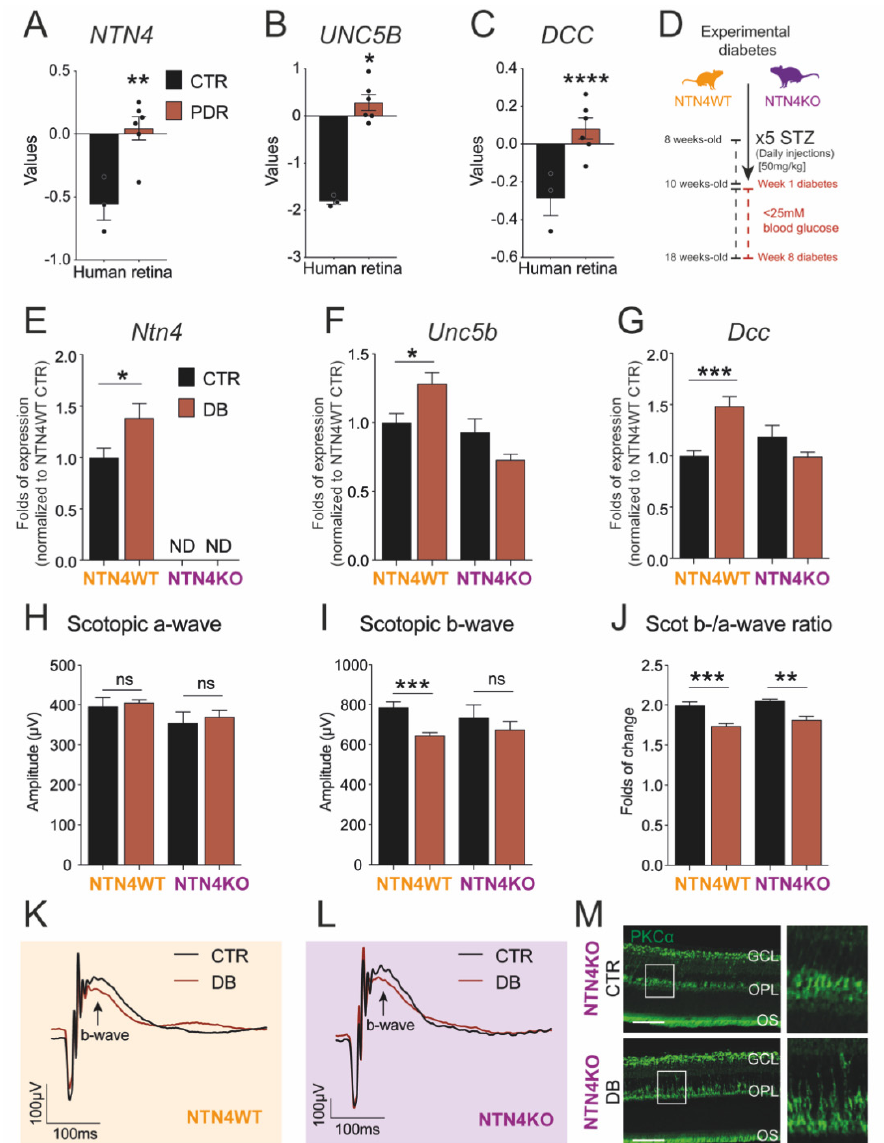
Figure 1. Diabetic retinopathy induces netrin − 4 upregulation and impacts visual function. ( A – C ) Bar charts represent NTN4 ( A ), UNC5B ( B ) and DCC ( C ) gene expression of human retina lysates comparing PDR patient samples ( n = 6 specimen) to control ( n = 3 specimen) Dataset: GSE60436. ( D ). Schematic illustrates the experimental diabetes model used via injection of streptozotocin (STZ) to obtain sustained hyperglycemia in both the NTN4WT and NTN4KO. ( E – G ). Bar charts represent mRNA folds of expression to NTN4WT control. Target gene expression of Ntn4 ( E ), Unc5b ( F ), and Dcc ( G ) were normalized to Ywhaz expression ( n = 3–8 animals per group and condition after 8 weeks diabetic). ( H – J ) Bar charts represent scotopic a − wave ( H ), scotopic b − wave ( I ), or the b − /a − wave ratio ( J ) of NTN4WT and NTN4KO animals 8 weeks after diabetes induction with their respective controls ( n = 4–8 animals per group). ( K , L ). Scotopic ERG curve representing the average values for either NTN4WT ( K ) or NTN4KO ( L ) animals. ( M ) Representative micrographs with the expression of PKC α (green) in cross − sections from NTN4KO control and diabetic mice ( n = 3 animals per group, 8 weeks of diabetes). White boxes indicate a detail of the micrograph (expanded in the right panel) depicting a slight delocalization of the bipolar cells in diabetes. Scale bar = 50µm. The asterisk stands for significant p -values when compared to intra-strain control (* = p < 0.05; ** = p < 0.01; *** = p < 0.001; **** = p < 0.0001; ns = not significant using Student t − test). CTR, control. PDR, proliferative diabetic retinopathy. DB, diabetic.